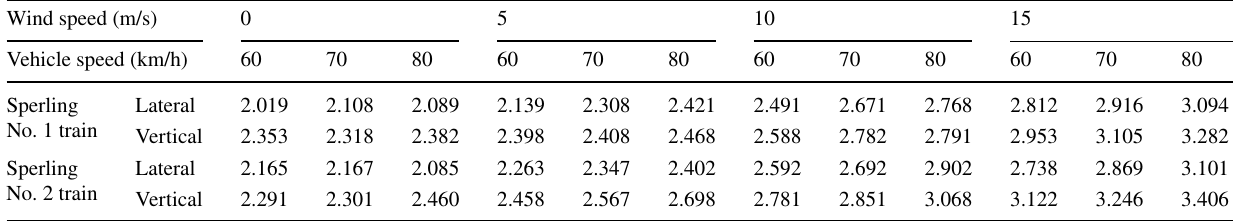
Table 3 Monorail vehicle Sperling coefficients in different conditions Wind speed (m/s) Vehicle speed